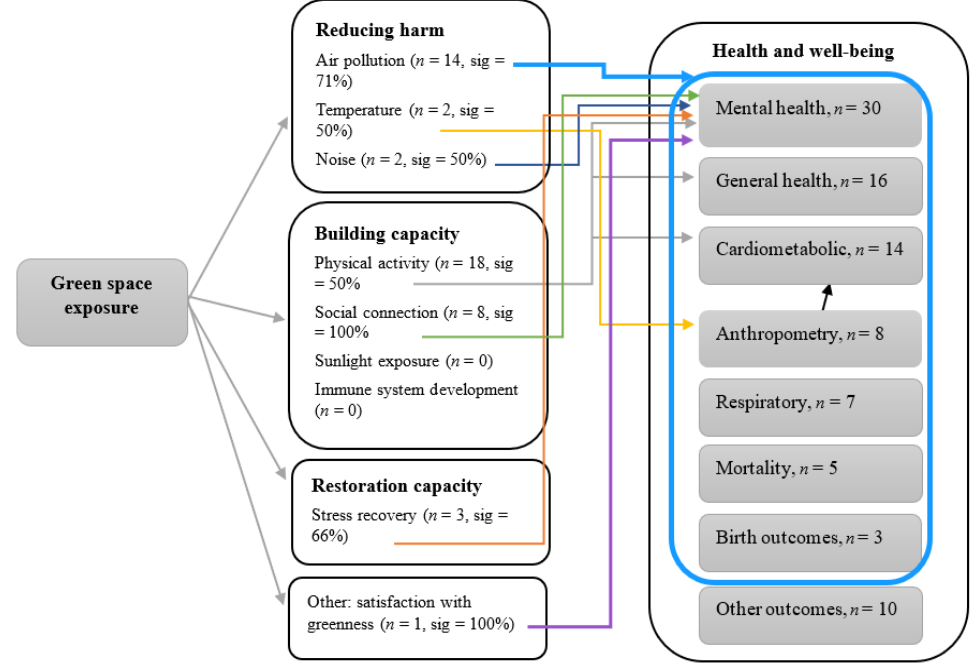
Figure 3. Pathways linking greenspace to health outcomes examined in the 73 studies in China. Arrows link particular pathways with health outcomes, with a single arrow from air pollution associated with all health outcomes contained within the blue circle. n , number of studies; sig, proportions of studies that found a significant effect of the mediator.